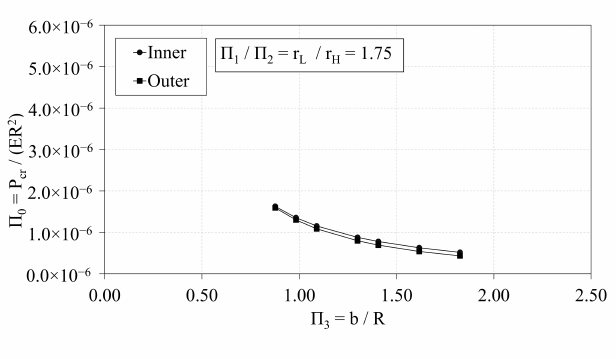
Figure 17. Π 0 vs. Π 3 of OLC and ILC